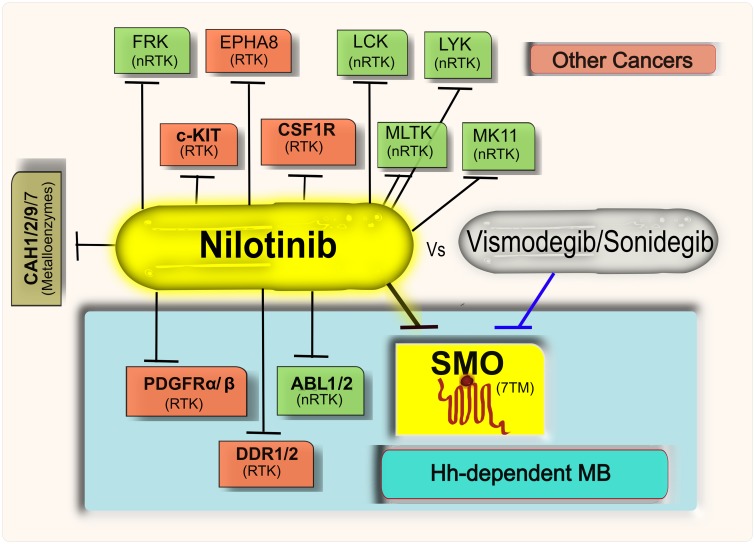
Multi-pathway pharmacology of Nilotinib vs SMO-specific drugs for Hh-dependent cancers.Targets of Nilotinib include the Hh-pathway (identified in this study) and several other pathways that are either already known to be dysregulated in Hh-dependent cancers or may serve as escape pathways and are implicated in other cancers. The ability of Nilotinib to inhibit multiple targets simultaneously in Hh-dependent cancers makes it suitable candidate for therapeutic candidate for personalized medicine as compared to specific SMO inhibitors like Vismodegib. Target type is shown by color. RTK stands for receptor tyrosine kinase and nRTK stands for non-receptor tyrosine kinase.